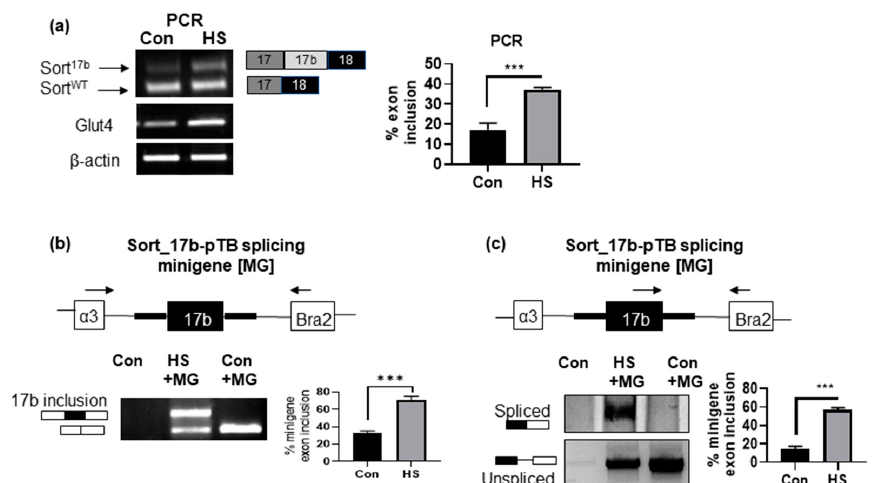
Figure 4. High serum (HS) method of insulin resistance promotes inclusion of sortilin exon 17b. ( a ) 3T3L1 cells were differentiated and on day 4, insulin resistance was induced by high serum for 48 h. Total RNA was isolated, PCR was performed using primers specific to sortilin exon 17 (sense) to exon 19 (anti-sense) to simultaneously detect both sortilin variants. The PCR products were separated on a 1% agarose gel, visualized using ethidium bromide staining and normalized to β -actin expression. ( n = 5). Graph represents endogenous percent inclusion of exon 17b, which was calculated using the Equation (1). Statistical analysis was performed by two tailed t -test; *** p < 0.001 between control and high serum (HS) samples. ( b ) Sort_17b-pTB splicing minigene (MG) was transfected into 3T3L1 adipocytes and treated with high serum for 48 h. The control samples had no minigene transfection. Total RNA was isolated, PCR was performed using primers on splice donor exon ( α 3, sense) to splice acceptor exon (Bra2, antisense) of the Sort_17b-pTB splicing minigene. The PCR products were separated on a 1% agarose gel and visualized using ethidium bromide staining ( n = 5). Graph represents percent exon 17b inclusion within Sort_17b-pTB splicing minigene (MG) in control vs. high serum, which was calculated using the Equation (2). Statistical analysis was performed by two tailed t -test; *** p < 0.001 between control and high serum (HS) samples. ( c ) PCR was performed using primer specific for sortilin exon 17b (sense) and splice acceptor exon (Bra2, antisense). The PCR products were separated on PAGE and visualized using silver staining ( n = 5). Graph represents percent exon 17b inclusion within Sort_17b-pTB splicing minigene (MG) in control vs. high serum, which was calculated using the Equation (2). Statistical analysis was performed by two tailed t -test; *** p < 0.001 between control and high serum (HS) samples.